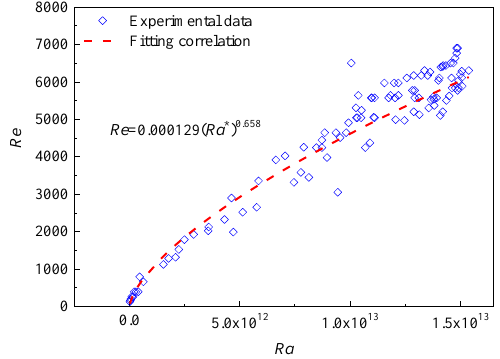
Figure 9. The relationship of Re and Ra.